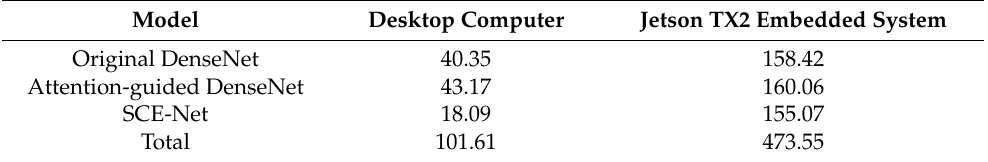
Table 12. Comparison of the processing time among the original DenseNet, attention-guided DenseNet, and SCE-Net (unit: